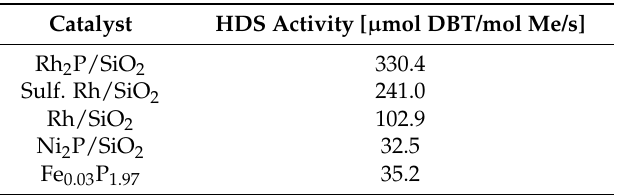
Table 4. Normalized HDS activity of different catalyst materials (275 ◦ C, 3.0 MPa, 3000 ppm DBT in decalin) [9].